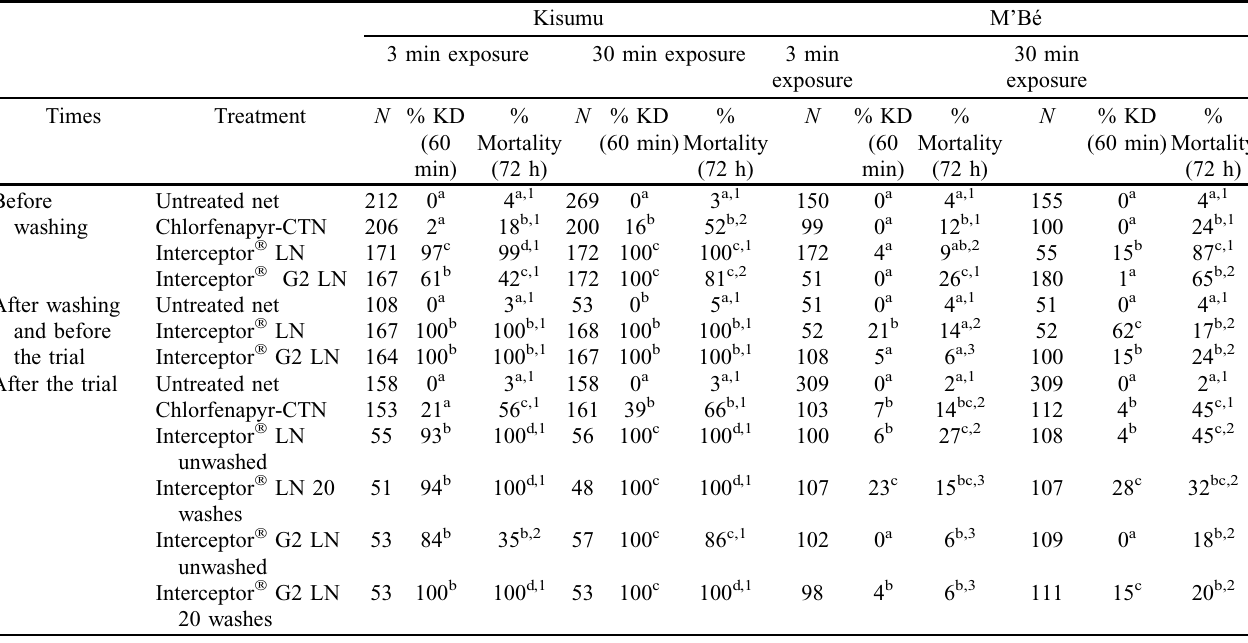
Table 2. The knockdown (KD) rate at 60 min and the mortality rate of Kisumu and the wild resistant strain M’Bé after a 3 min and a 30 min exposure to treated nets following WHO standard procedures (WHO 2013) before washing, after washing, and after the field trial. Kisumu